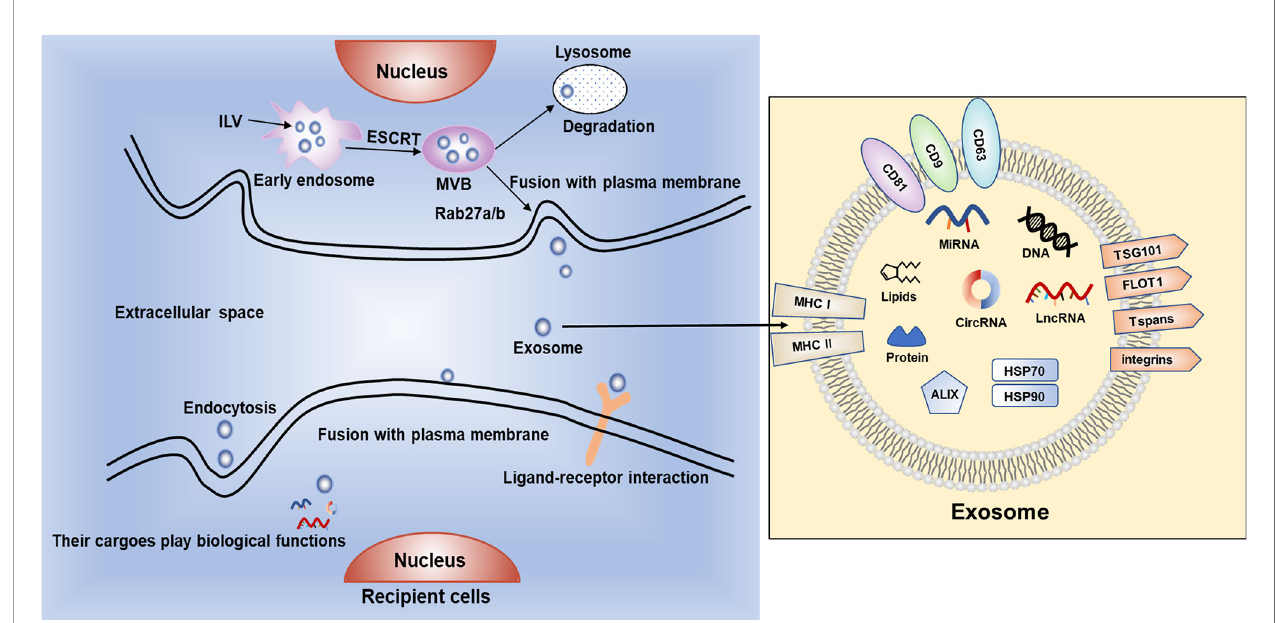
FIGURE 1 | The biogenesis, secretion and uptake of exosomes. Exosomes contain bioactive cargoes including RNAs, DNAs, proteins and lipids. With the help of endosomal sorting complex required for transport (ESCRT), intraluminal vesicles (ILVs) are produced when early endosomes develop to multivesicular bodies (MVBs). Then, MVBs can be degraded by lysosomes or fuse with cell membrane and release exosomes into extracellular space. Exosomes can be ingested by recipient cells by endocytosis or fusing with plasma membrane, or through ligand – receptor interaction to exert various biological